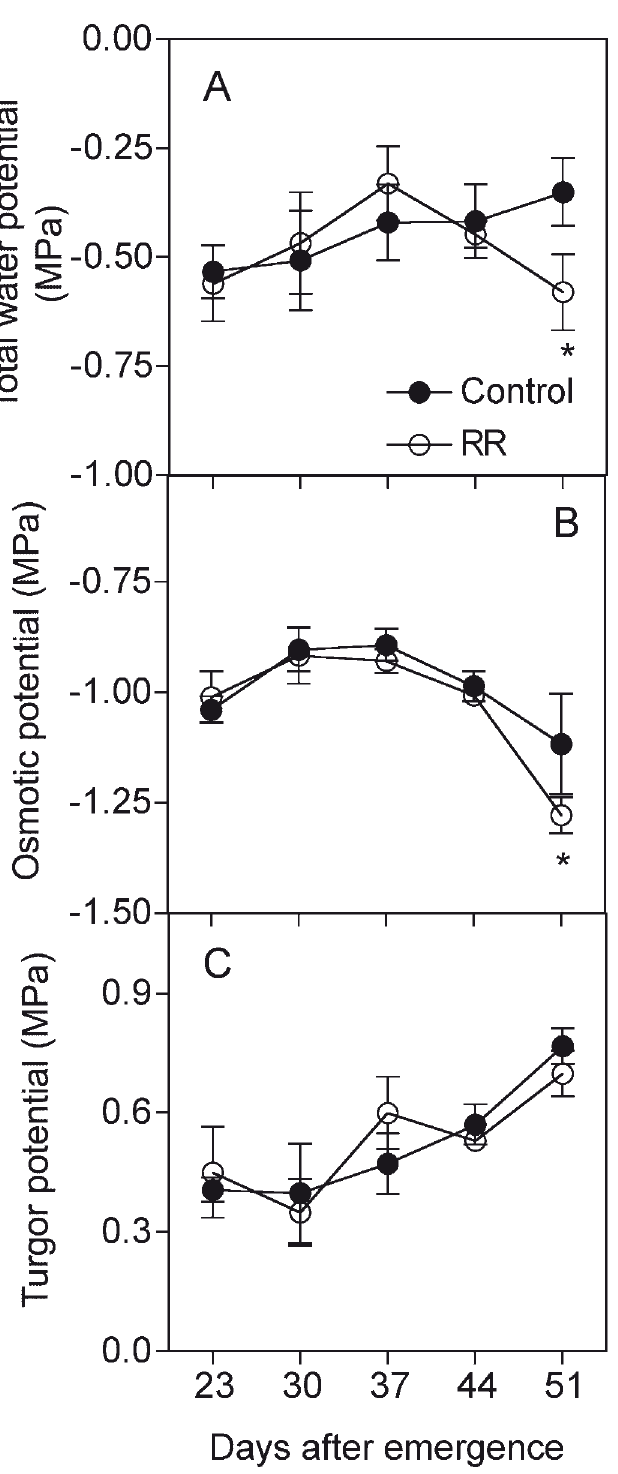
Fig. 4 - Leaf water status determined at weekly intervals from day 23 to the end of the experiment in both control and root-restricted (RR) plants:total water potential (A), osmotic potential (B) and turgor (C). * indicates significantly different values for P≤0.05 (n=5), when means were separated by Duncan’s test.